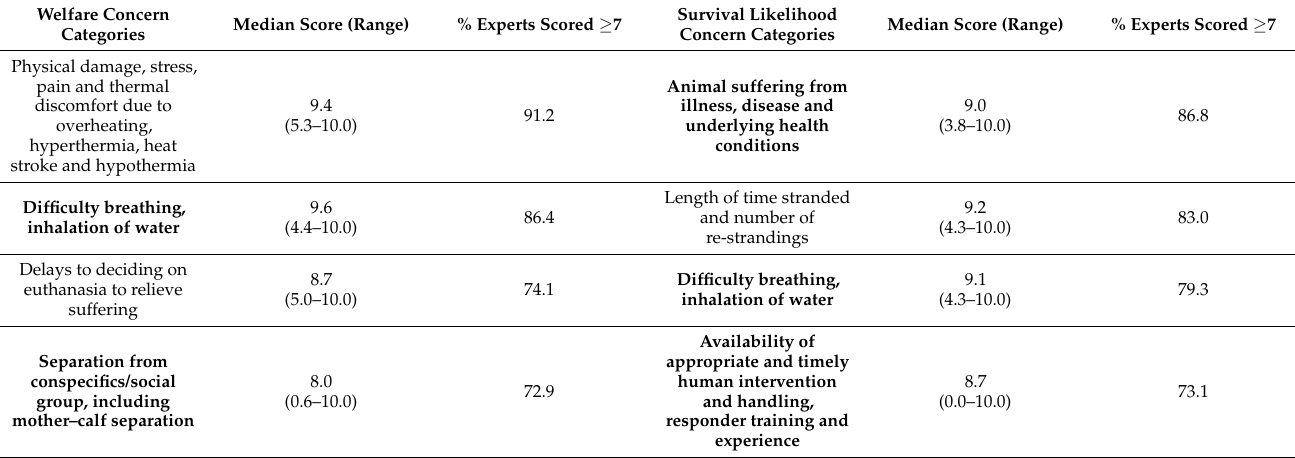
Table 3. The major categories for concerns about welfare and survival likelihood arising from reflexive thematic analysis of participant responses to questionnaire 1, and median score and range for each category from questionnaire 2. Categories are ranked by the percentage of experts that scored them as having severely bad effects (scores in ≥ 7 grouping). Categories above the bold line reached consensus ( ≥ 70%). Concern categories that overlapped for welfare and survival likelihood are shown in